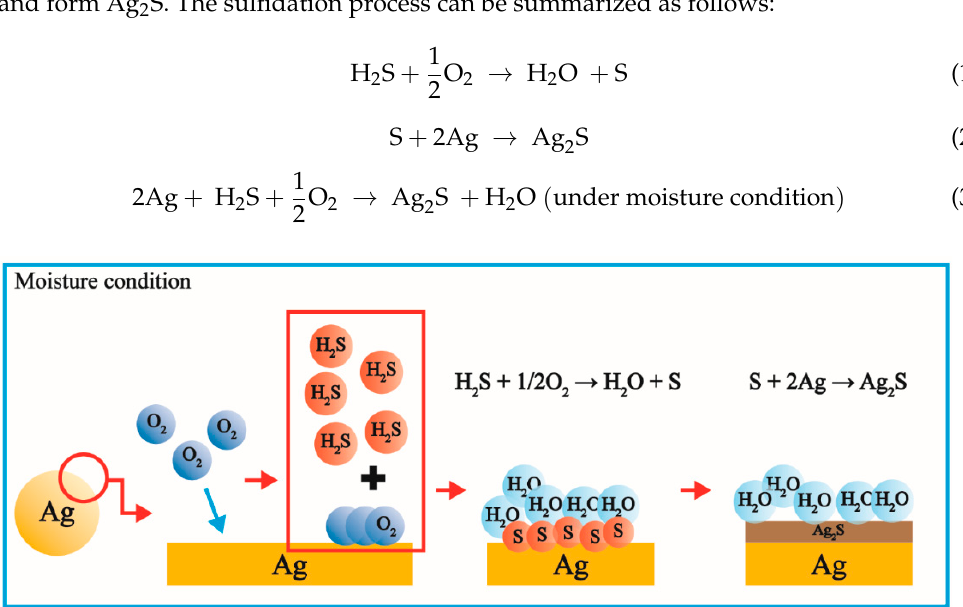
Figure 6. Photographs of C-0.22Ag film after reaction with 2 ppm H 2 S.